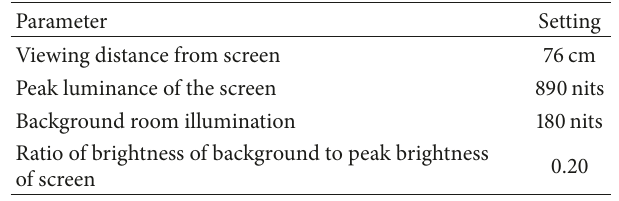
Table 4: Simulation parameters. Table 5: Viewing